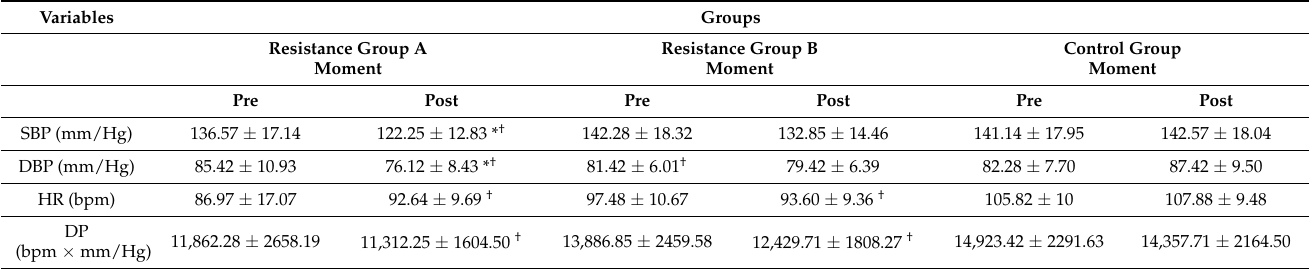
Table 2. Hemodynamic assessment before and after the intervention for training and Control groups. Variables